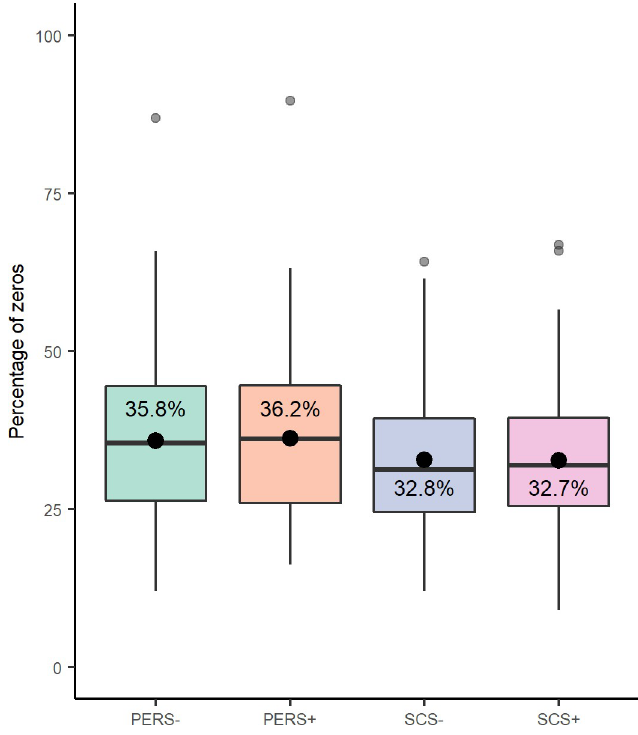
Fig 1. Percentage of zero values in data by genetic line. SCS+ and SCS- as somatic cell score lines susceptibility/ resistance, and PERS+ and PERS- as milk persistency line high/low persistence.